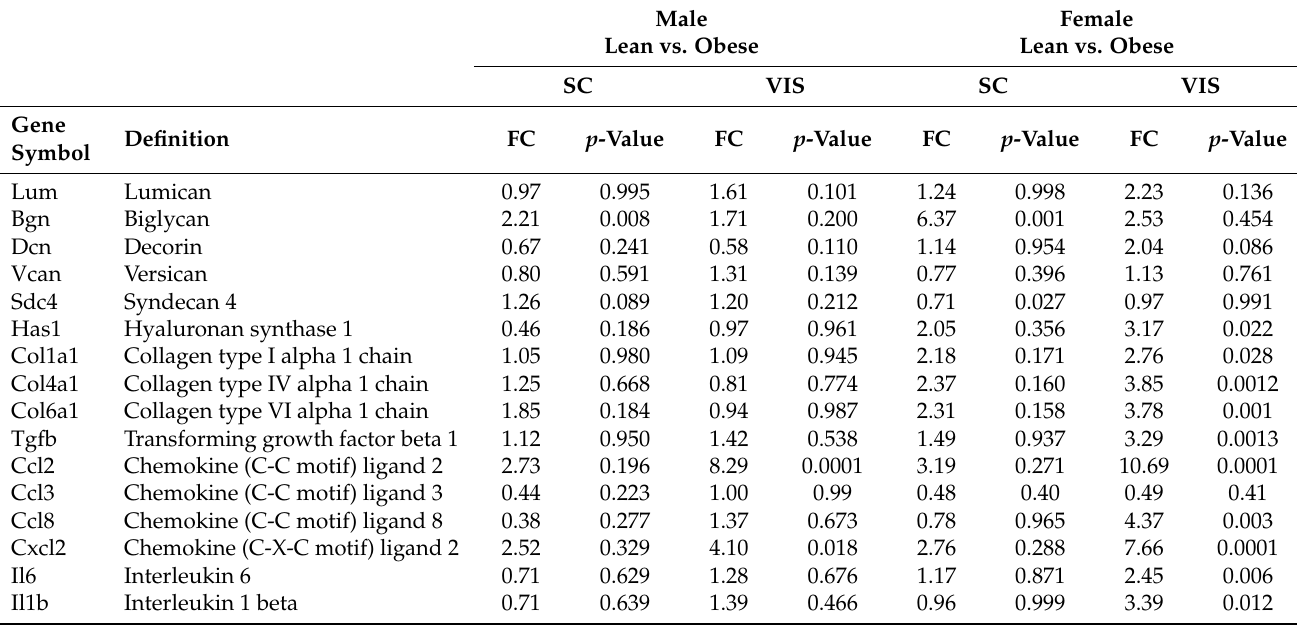
Table 6. Relative mRNA expression of proteoglycan, collagen, chemokines, and interleukins in intraperitoneal subcutaneous (SC) and visceral (VIS) adipose tissues of obese mice fed a high-fat diet for 10 weeks compared to those in lean mice fed a low-fat diet. A two-way ANOVA test was used where obesity and adipose tissue depots were taken as variables. The Shapiro–Wilk test was used to test the normality of the data. Male Female Lean vs. Obese Lean vs. Obese